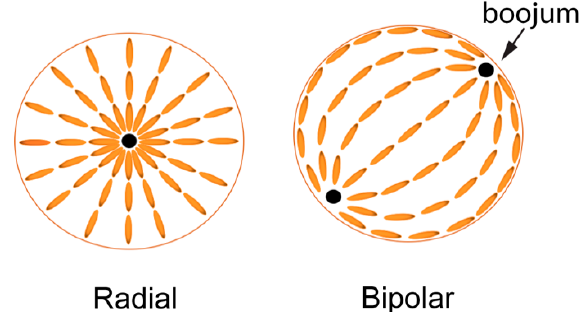
Figure 8. Configurations of radial and bipolar droplets. In the radial droplet, molecules lie perpendicular to the droplet surface trapping a +1 or hedgehog defect in the middle while in the bipolar droplet, molecules lie parallel to the surface confining two boojums at the surface.